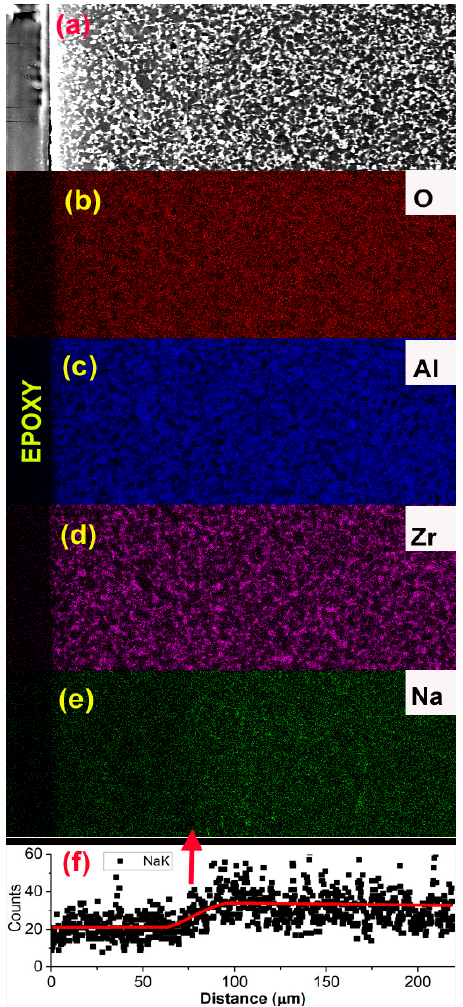
Figure 2. ( a ) An SEM image of a sample that had been ion exchanged at 300 °C in LiNO 3 for 2 h. 2 h. The micrograph shows ~250 microns of the sample. The microstructure is similar to that in Figure 1. ( b – d ) show respectively EDS maps of O, Al and Zr. All three are uniform through the width of the image. ( e ) An EDS map of Na. As seen in the map, there is a distinct change in color at approximately 80 microns. This suggests that in 2 h, lithium ion exchange had occurred to a depth of about 80 microns. The demarcation line is marked by a red arrow. ( f ) Actual EDS counts of Na showing a distinct change in counts at about 80